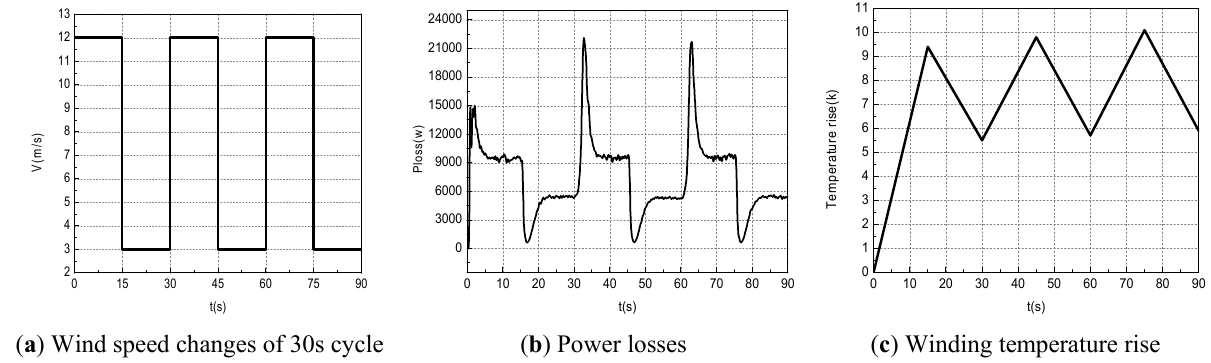
Figure 10. Power losses and temperature rise of stator windings for wind speed change with a 30 s cycle.